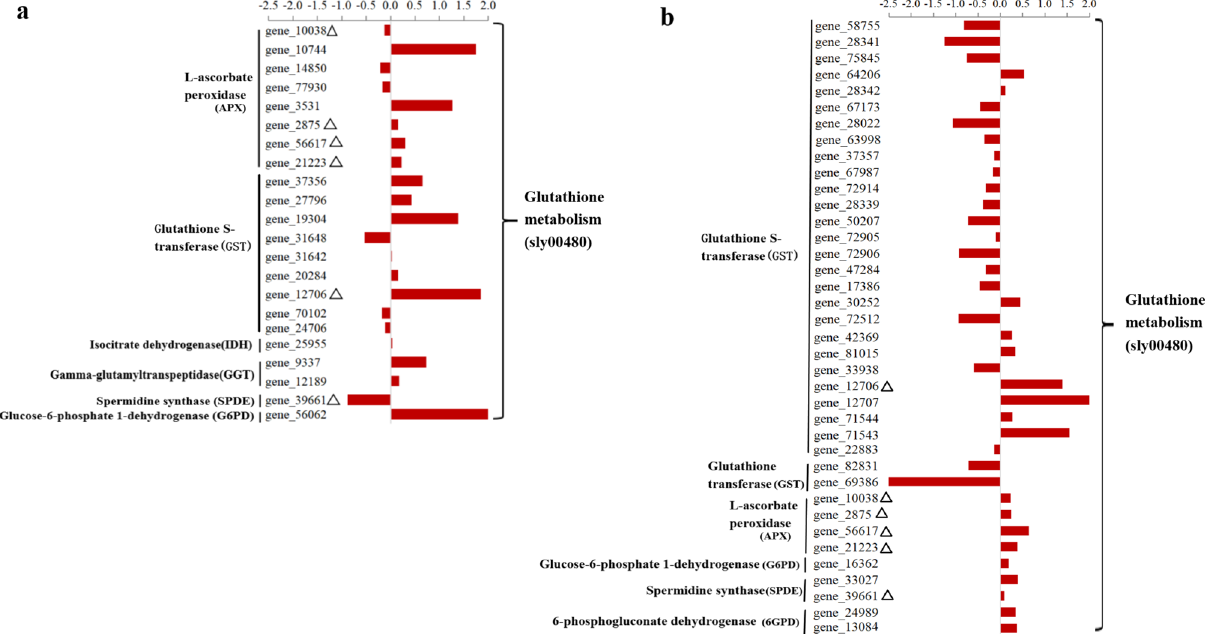
Figure 6. Comparison of the expression of genes associated with glutathione metabolism in resistant and susceptible cultivars in response to Ralstonia solanacearum infection. The bar represents log 2 (In-R/In-S), where In-R and In-S are read count values of the gene in resistant and susceptible cultivars induced by R. solanacearum . Comparison of the expression of genes in resistant and susceptible cultivars in response to R. solanacearum infection at 3 dpi ( a ) and 7 dpi ( b ). Δ indicated common differentially expressed genes enriched in the glutathione metabolism at 3 and 7